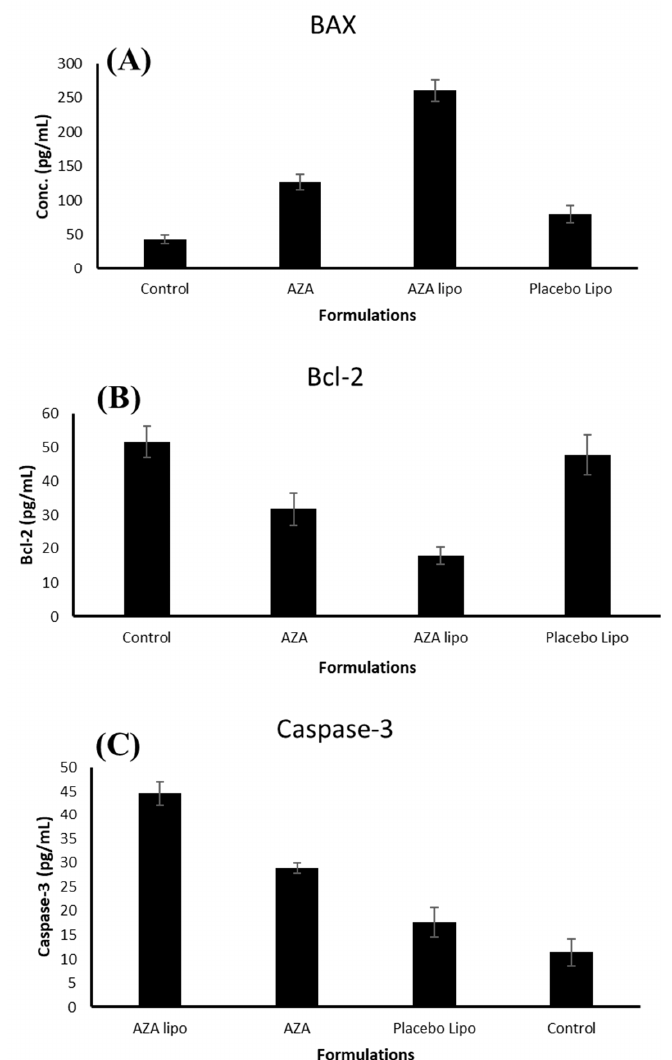
Figure 10. Effect of the IC50 concentrations of fee AZA, placebo liposomes and AZA-Lipo on the expression of Bax, Bcl-2 protein and caspase-3 activity in A549 cancer cells ( p < 0.05 for free AZA vs. AZA Lipo